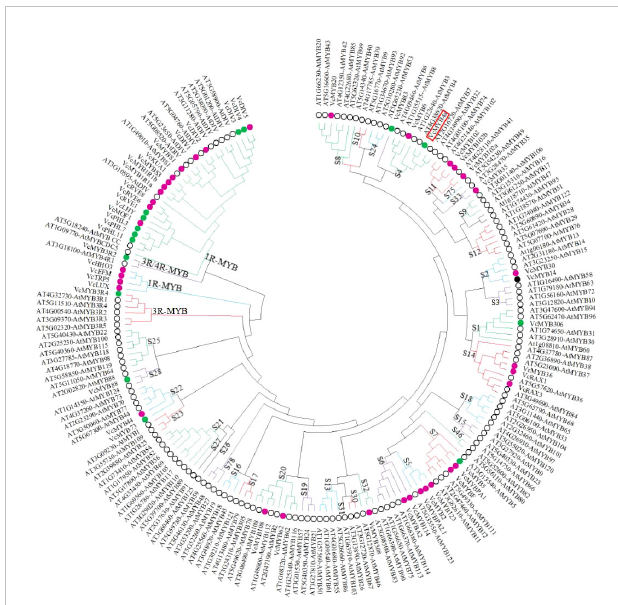
FIGURE 2 The 52 differentially expressed VcMYB transcription factor genes from blueberry and 142 MYB transcription factor genes from Arabidopsis thaliana were clustered into different subgroups using MEGA X with the neighbor-joining method. Magenta, green, and black dots represent upregulated, downregulated, and both up- and downregulated VcMYBs under UV-B radiation, respectively. Black circle represents MYB transcription factors from Arabidopsis. Red box indicates the position of VcMYB4a